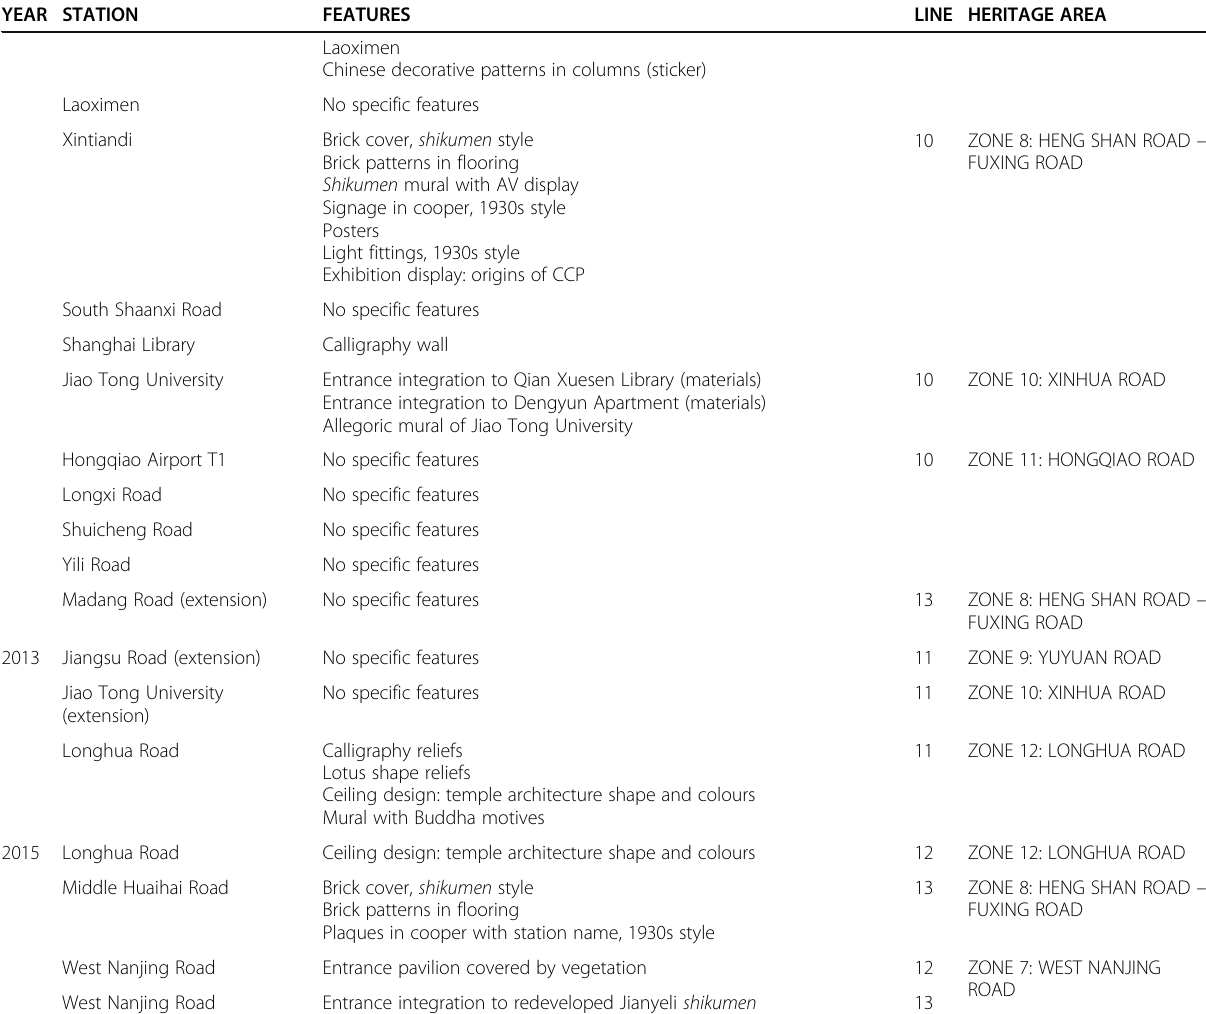
Table 2 Main cultural features incorporated to metro stations